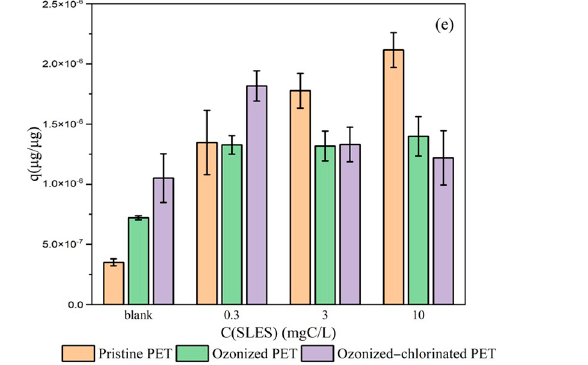
Figure 9. The influence of ( a ) pH, ( b ) kind of anion, ( c ) kind of cation, ( d ) humic acid concentration, ( e ) anion surfactant concentration on TBM sorption to PET with the different oxidation processes. The initial concentration of TBM was 10 µ g/L. All the adsorption experiments were conducted at pH = 7 and 20 °C.